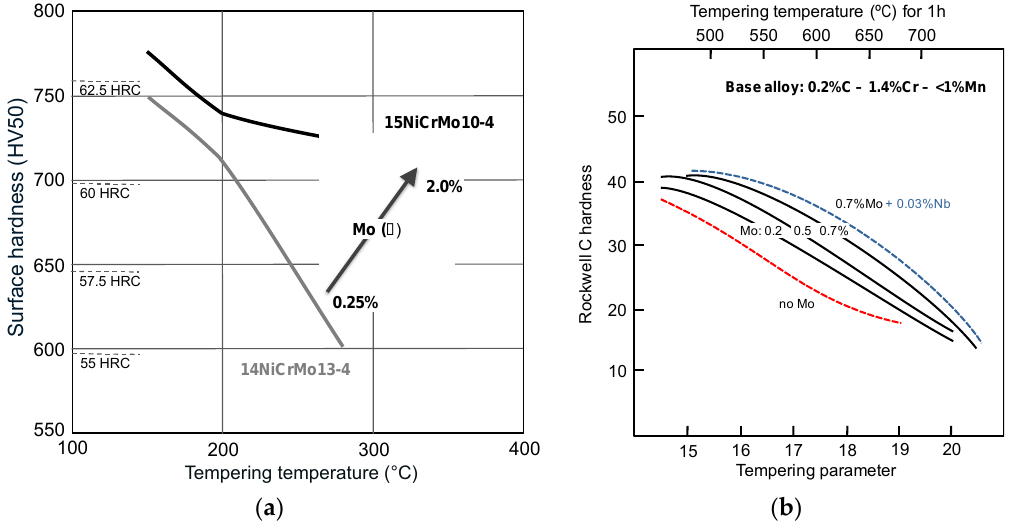
Figure 12. Increasing tempering resistance in carburizing steel: ( a ) surface hardness of the carburized layer in relation to tempering temperature and the effect of increased molybdenum content; ( b ) effect of tempering resistance as a function of the molybdenum content and synergy effect with niobium (tempering parameter = T × (20 + log t ) × 10 − 3 ( T in K, t in h)).